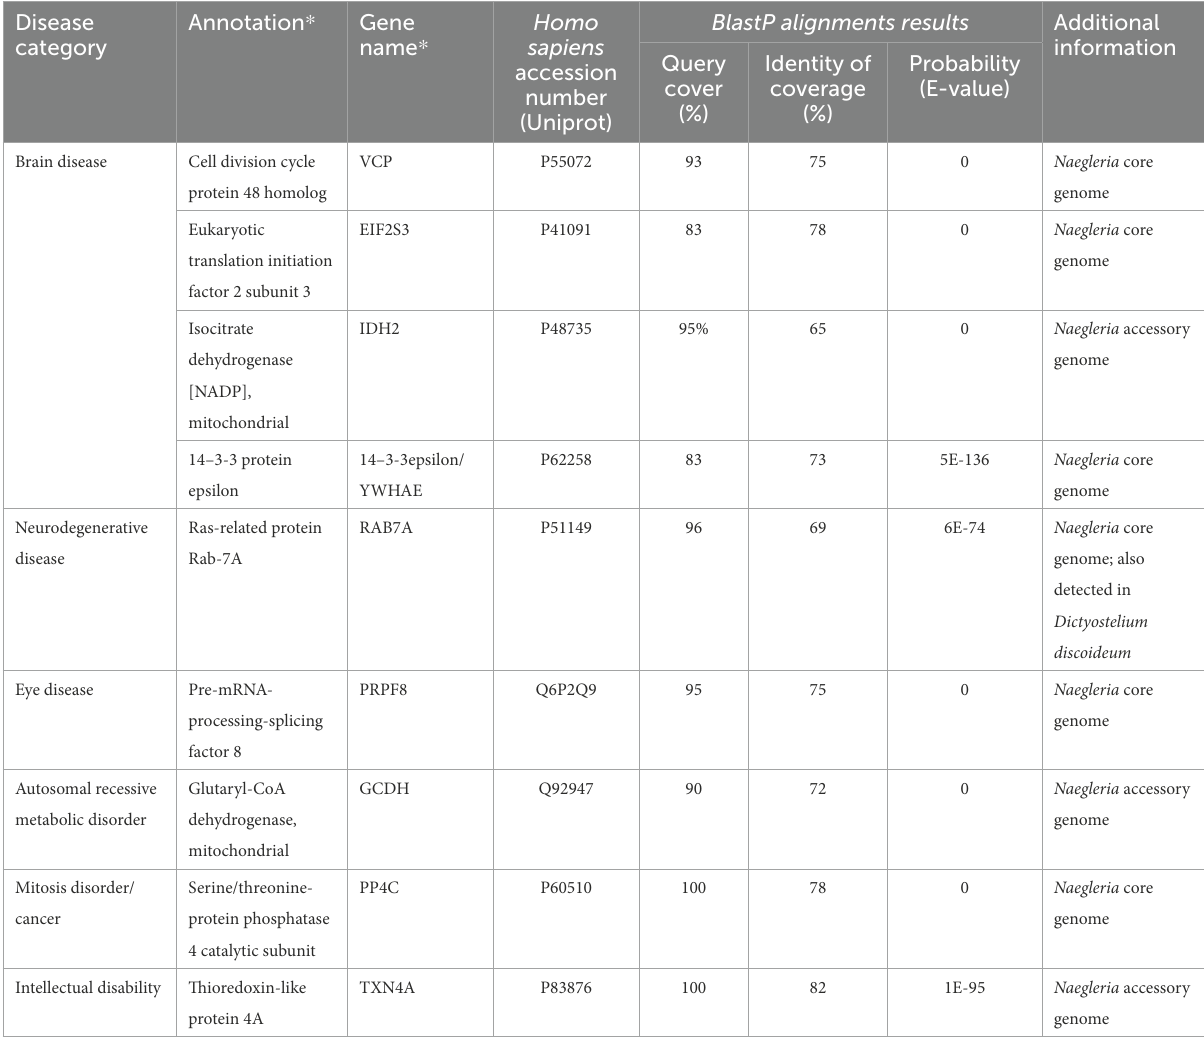
TABLE 2 Comparative analyses of Naegleria and human protein